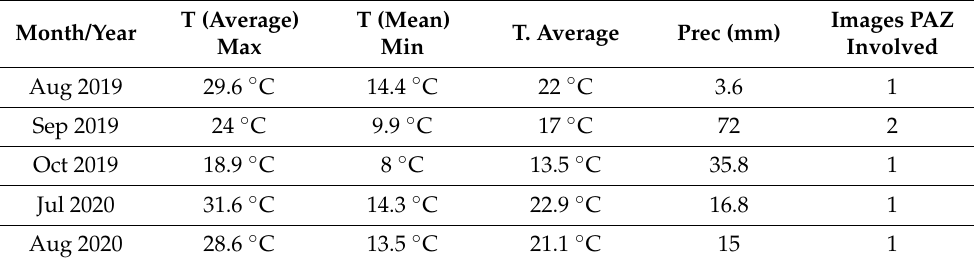
Table 2. Source data from the AEMET meteorological station of Coruña del Conde (Burgos). (Web source database: https://es.meteosolana.net/estacion/2106B, accessed on 23 April 2021).